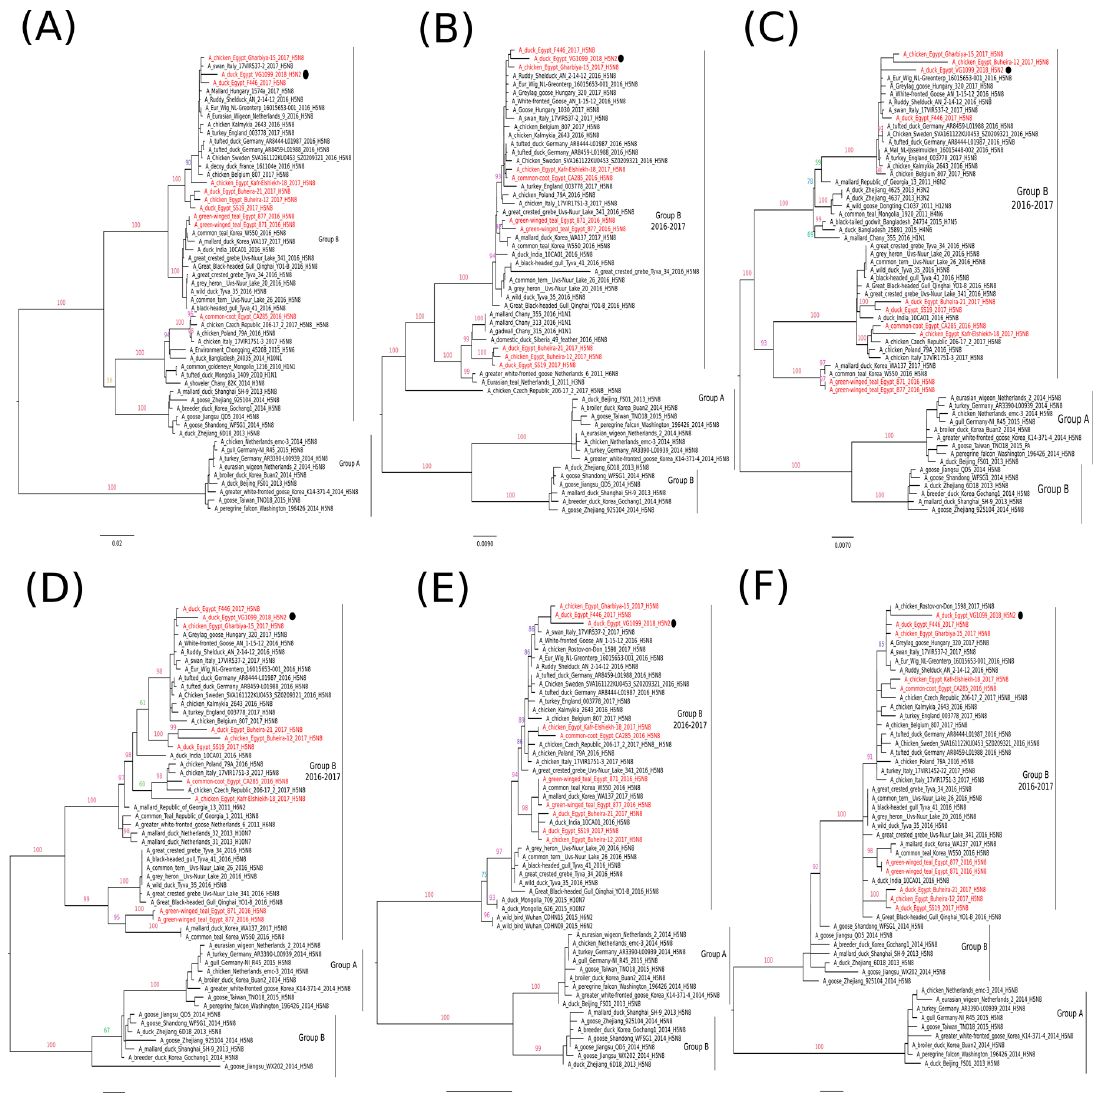
Figure 2. Phylogenetic trees of the nucleotide sequences of the gene segments PB2, PB1, PA, NP, M, and NS ( A – F ). Maximum likelihood calculations were done with the IQTree software under the best fit model according to the Bayesian criterion. Egyptian HPAI H5N8 viruses are colored in red and the H5N2 virus is indicated with a black dot.